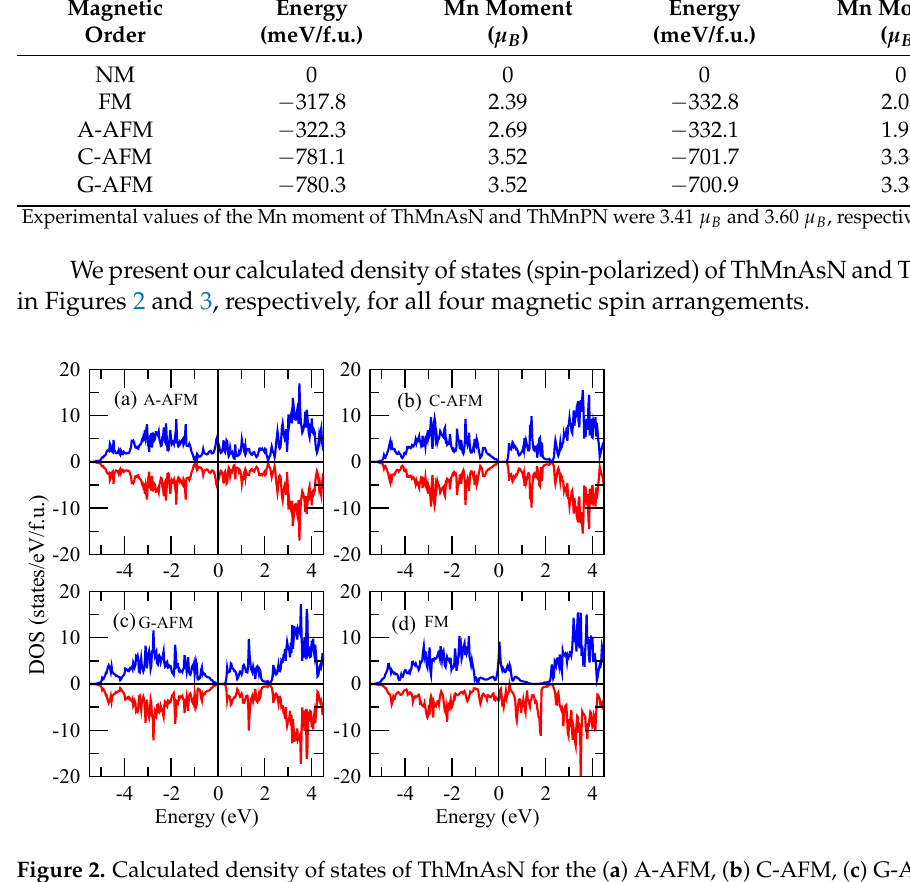
Figure 2. Calculated density of states of ThMnAsN for the ( a ) A-AFM, ( b ) C-AFM, ( c ) G-AFM, and ( d ) FM spin arrangements. the up-spin and down-spin density of states are indicated by blue and red lines, respectively. The Fermi level is denoted by a vertical black line at E = 0 eV.